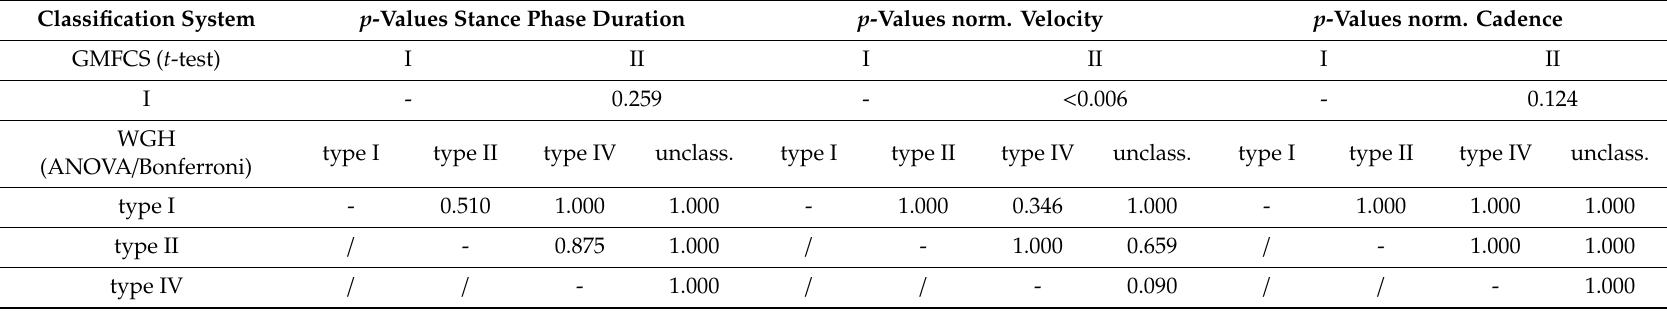
Table 3. Comparative statistics of the di ff erent spatiotemporal parameters between GMFCS levels and between WGH types. Classification